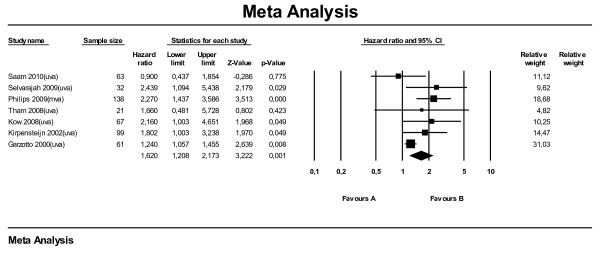
Meta-analysis of univariate and multivariate data sets for predictive value of serum alkaline phosphatase level on survival time using hazard ratios.